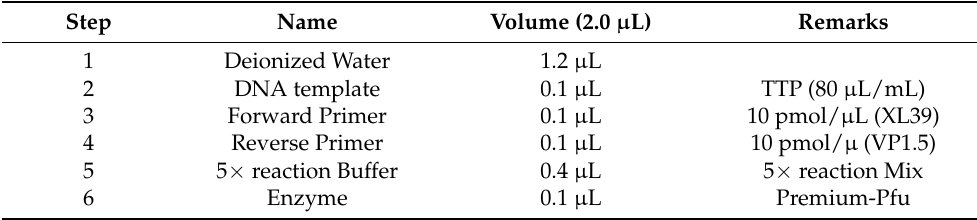
Table 1. Composition ratio of sample for PCR.